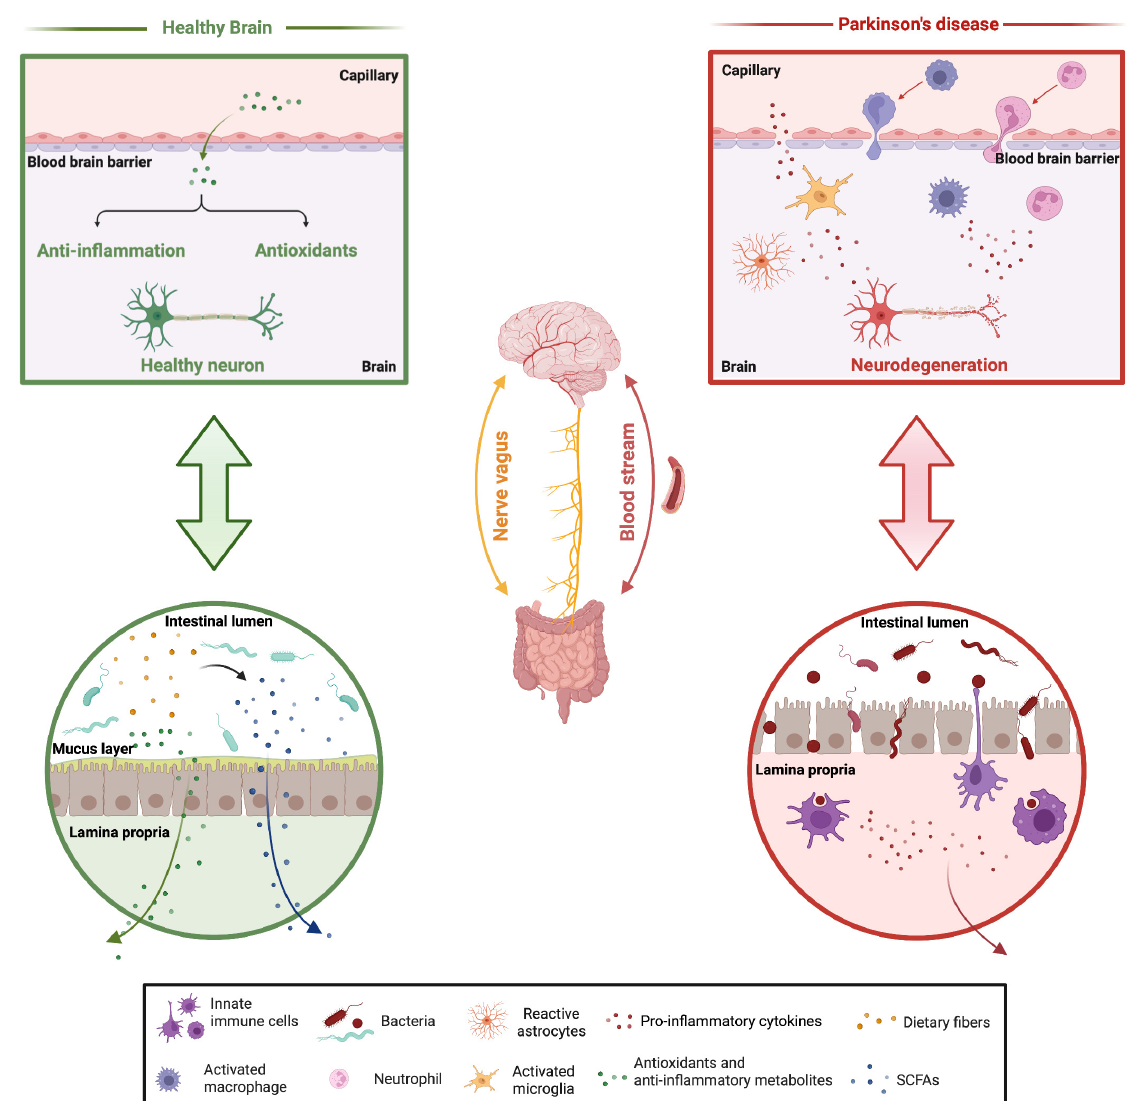
Figure 1. Proposed contribution of gut dysbiosis to PD. In healthy individuals, the gut microorgan- isms participate in the formation of the intestinal mucosal layers through the synthesis of SCFAs and regulate the host immune response. They also participate in the production of antioxidant and anti-inflammatory metabolites that can reach the brain where they exert neuroprotection. In PD patients, alterations in the gut microbiota population affect the production of SCFAs leading to gut permeability. At the same time, pro-inflammatory cytokines are produced that enhance the systemic inflammatory response. Long-term activation of peripheral immune cells promotes the breakage of the blood-brain barrier, leading to chronic neuroinflammation (created with BioRender.com, accessed on 12 October 2022).